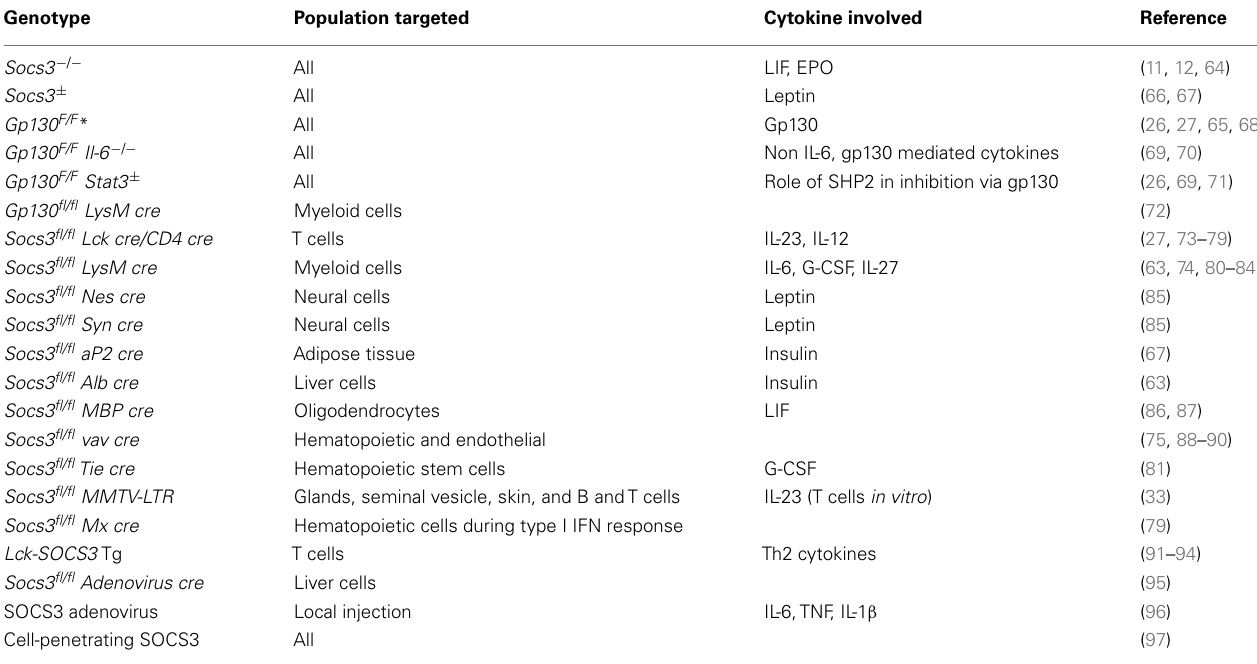
Table 2 | Mouse models to study SOCS3